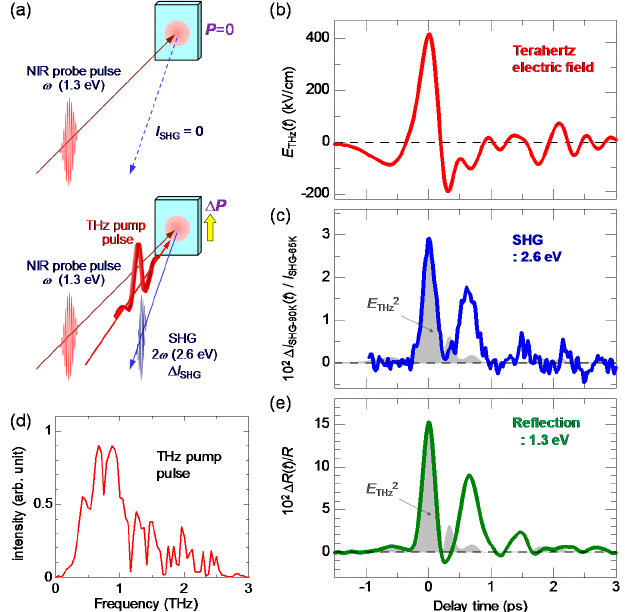
Figure 24. Results of terahertz-pump SHG-probe and optical-reflectivity-probe measurements in the paraelectric N phase (90 K) of TTF-CA [42]. ( a ) Schematics of terahertz-pump SHG-probe measurement in the neutral phase; ( b ) Electric-field waveform of a terahertz pulse ( E THz ); ( c ) Time evolution of an SH intensity at 90 K by a terahertz electric-field pulse shown in ( b ); ( d ) Fourier power spectrum of a terahertz electric-field pulse shown in ( b ); ( e ) The time evolution of reflectivity change at 1.3 eV and at 90 K. Shaded area in ( c , e ) shows a waveform of the square of a terahertz electric field ( E THz ( t )) 2